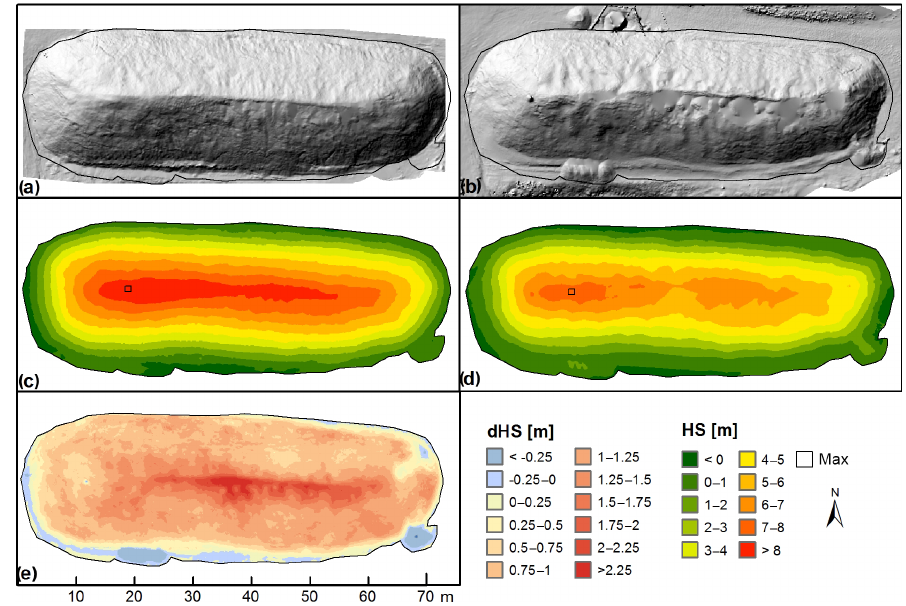
Figure 5. Flüela snow heap: hillshade images from (a) 29 April and (b) 8 October, snow heights HS (c, d) and snow height change dHS (e) . The location of the maximum HS on 29 April is indicated in panels (c) and (d) .